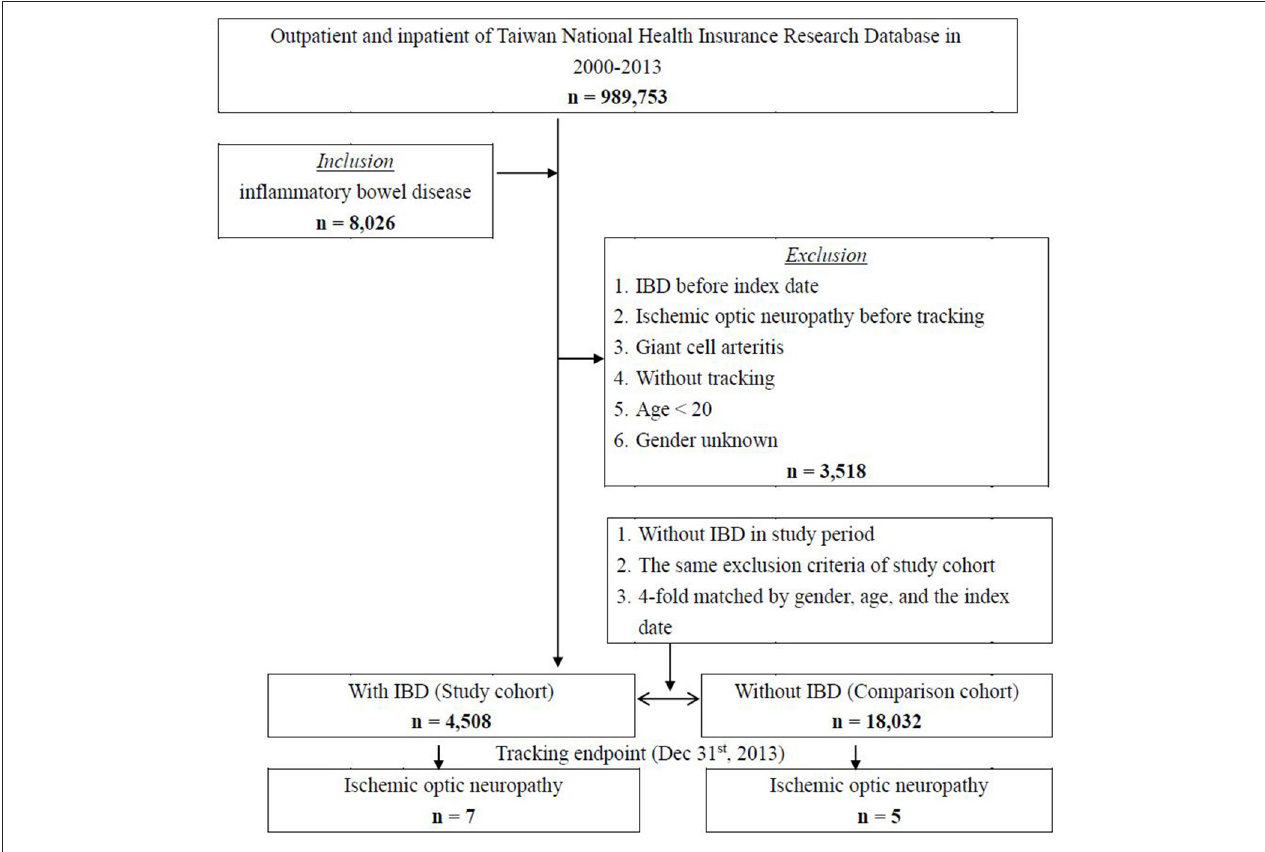
FIGURE 1 | Flowchart of the patient selection in this